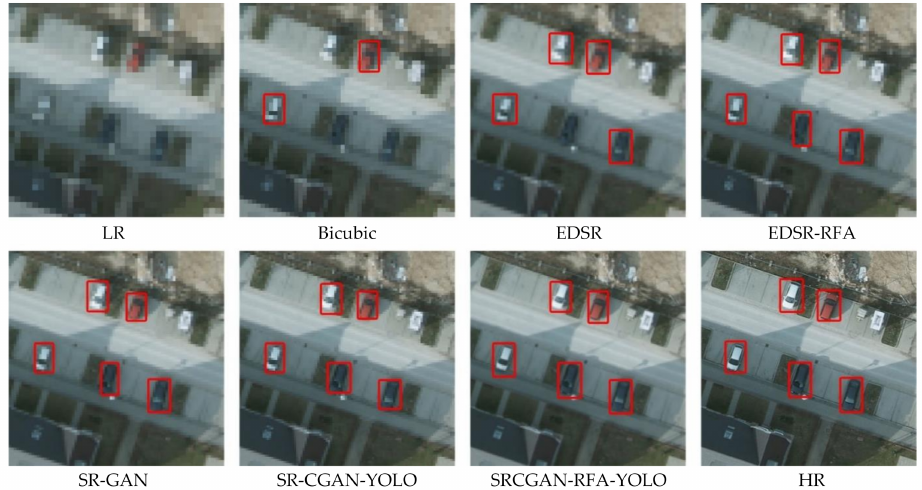
Figure 12. Detection examples using YOLOv3 as detector network.